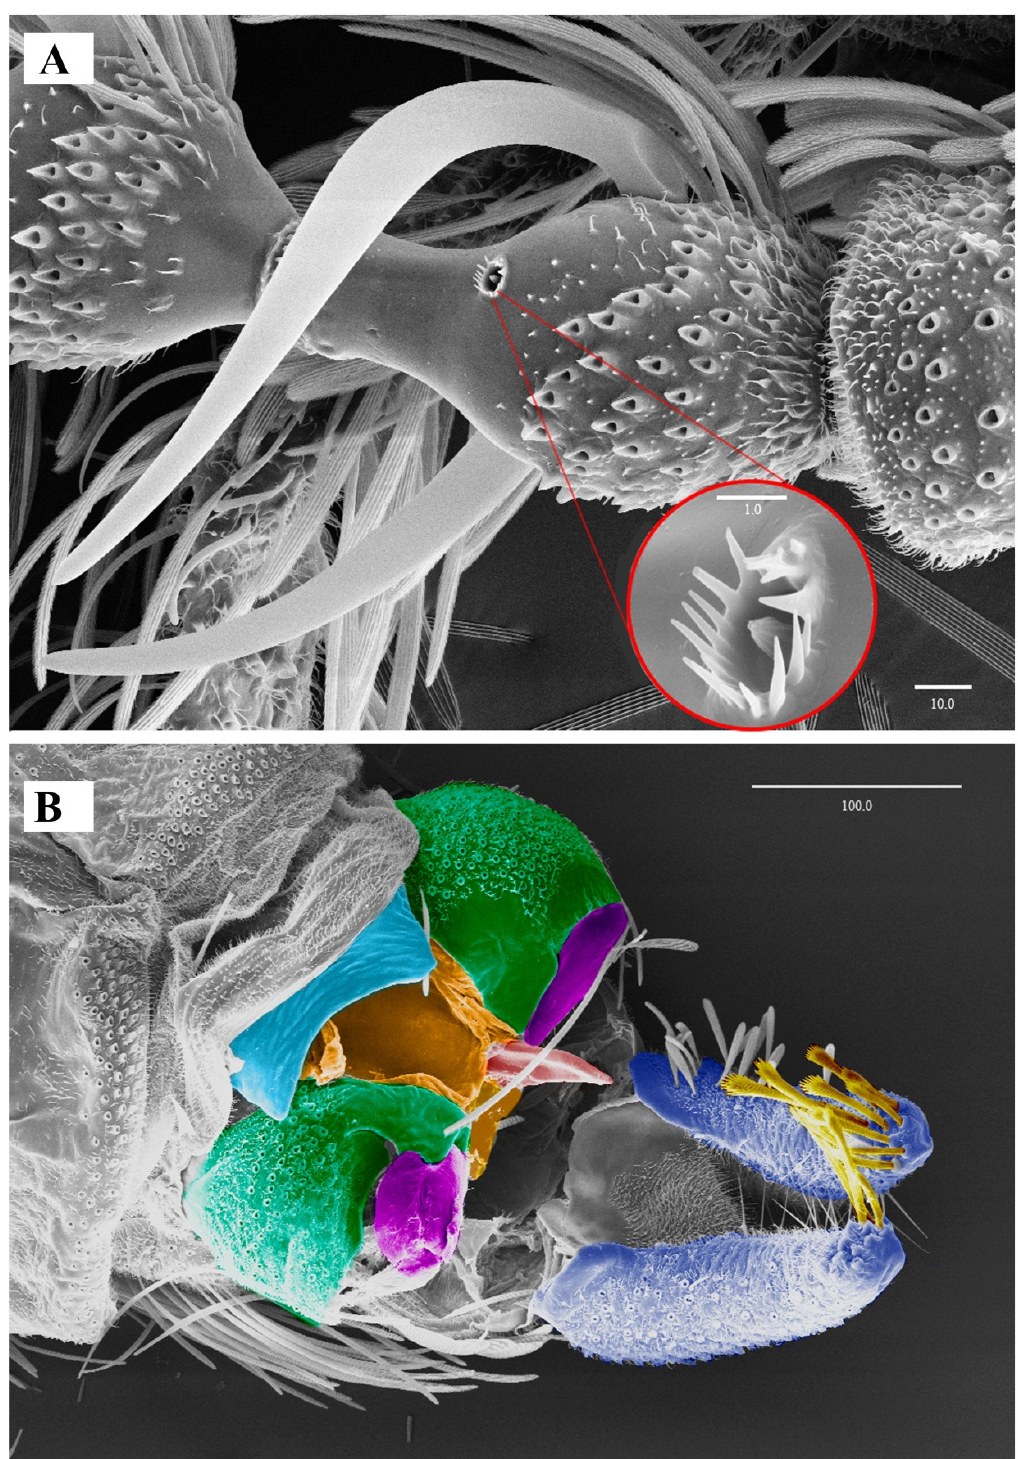
Figure 6. Lepiseodina latipennis ( Sarà, 1953), male. SEM pictures. ( A ) First flagellomere (3rd antennal segment), red circle higher magnification of sensilla. ( B ) Genitalia, light blue = hypandrium, orange = aedeagal sheath, green = gonocoxites, purple = gonostyli, red = aedeagus, dark blue = hypopods, yellow = tenacula. Scale ( A , B ) in micrometers ( μ m).